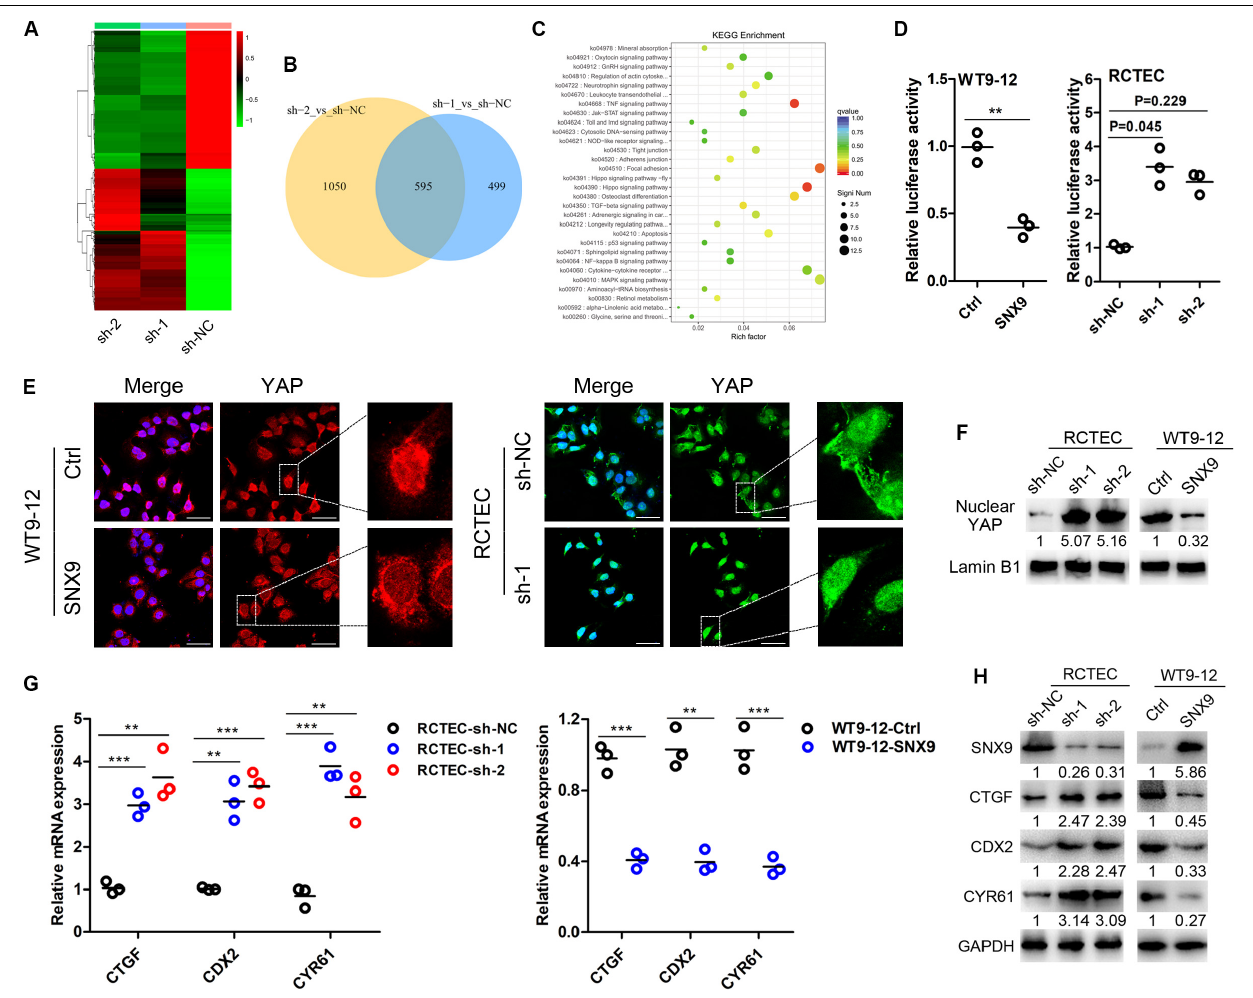
FIGURE 4 | SNX9 activates the Hippo signaling pathway in ADPKD cells. (A) RNA sequencing analysis was conducted in SNX9-depleted RCTEC (sh-1 and sh-2) and control (sh-NC) cells. (B) A Venn diagram showing the differentially expressed genes (DEGs) identified in cells transfected with each of the two SNX9 shRNAs, as identified by RNA-sequencing analysis. (C) KEGG analysis of the RNA-seq data from SNX9-depleted RCTEC and control cells. (D) YAP/TEAD4 luciferase reporter assay was performed in WT9-12 and RCTEC cells with modified SNX9 expression levels. Data are presented with scatterplots and mean values, n = 3. For WT9-12 cells, **indicates P < 0.01 by Student’s t -test. For RCTEC cells, a boundary significant trend was observed among the sh-NC, sh-1 and sh-2 groups ( P = 0.051) using Kruskal–Wallis H test. Compared with sh-NC group, the YAP/TEAD4 transcriptional activity was significantly promoted by transfection of sh-1 ( P = 0.045), but not by sh-2 ( P = 0.229) using Nemenyi test. (E) Representative immunofluorescence images of the indicated cells show the subcellular YAP localization. YAP was stained with red color in WT9-12 cells and green color in RCTEC cells. The nuclei were counterstained with DAPI (blue). Scale bars, 50 µ m. (F) Nuclear fractions were prepared and then subjected to western blot analysis to detect nuclear YAP protein levels. Lamin B1 was used as a loading control. (G) qRT-PCR analysis was performed to examine the mRNA expression levels of the Hippo target genes. Data are presented with scatterplots and mean values, n = 3. **Indicates P < 0.01; ***indicates P < 0.001 by Student’s t -test. (H) Western blot analysis was conducted to explore the protein levels of the Hippo target